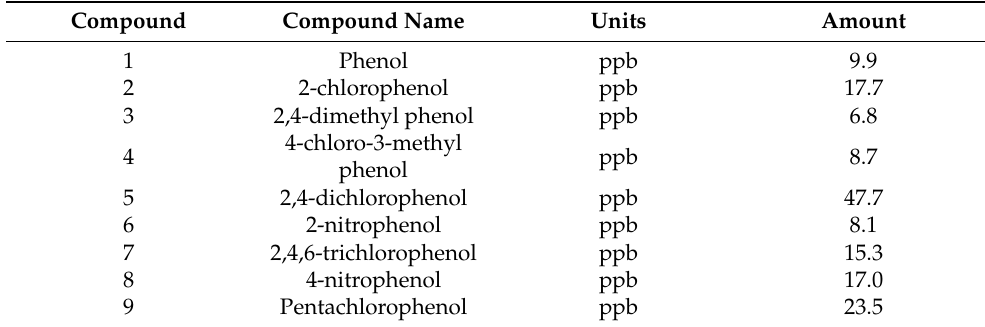
Table 2. The phenolic compounds of nettle essential oil identified by gas chromatography mass spectrometry